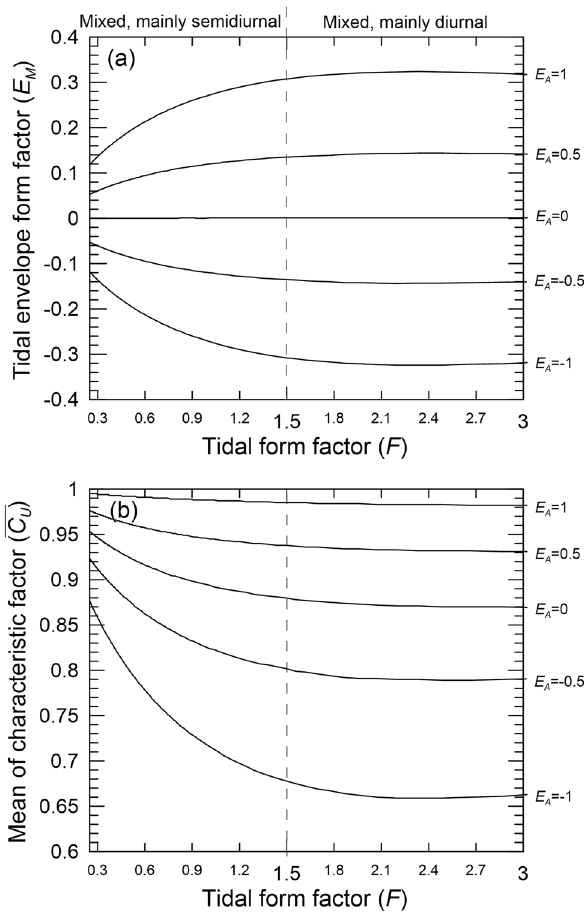
Figure 6. Variations in ( a ) the universal monthly tidal envelope form factor E M and ( b ) the mean upper tidal characteristic function C U , corresponding to changes in daily tidal form ( F ) from across the mixed mainly semidiurnal ( 0.25 < F < 1.5 ) and mixed mainly diurnal ( 1.5 < F < 3 ) regime ranges, for experimental cases where the phase lag differences ( E A = cos ( I E ), I E = ( g K 1 + g O 1 ) − g M ) are E A = ± 1, ± 0.5 and 0. Note that 2 the C U results for cases where E A = 1 , E A = − 1 , E A = 0.5 and E A = − 0.5 are equivalent to the C L results (not shown) for cases where E A = − 1 , E A = 1 , E A = − 0.5 and E A = 0.5 ,